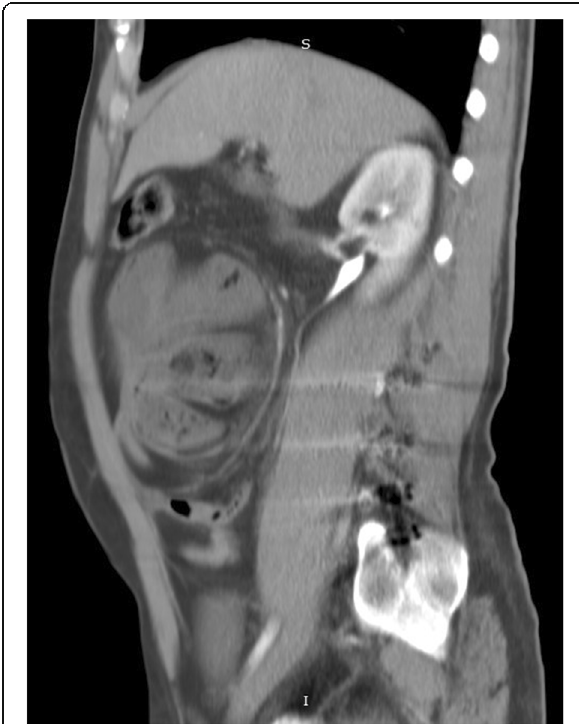
Fig. 4 Maximum intensity projection (MIP) sagittal reformatted image, showing the peritoneal sac splaying the mesenteric vessels and the cocooned, dilated small bowel loops within the sac. Note the horizontal streak artifact from lumbar metal prosthesis (not shown)